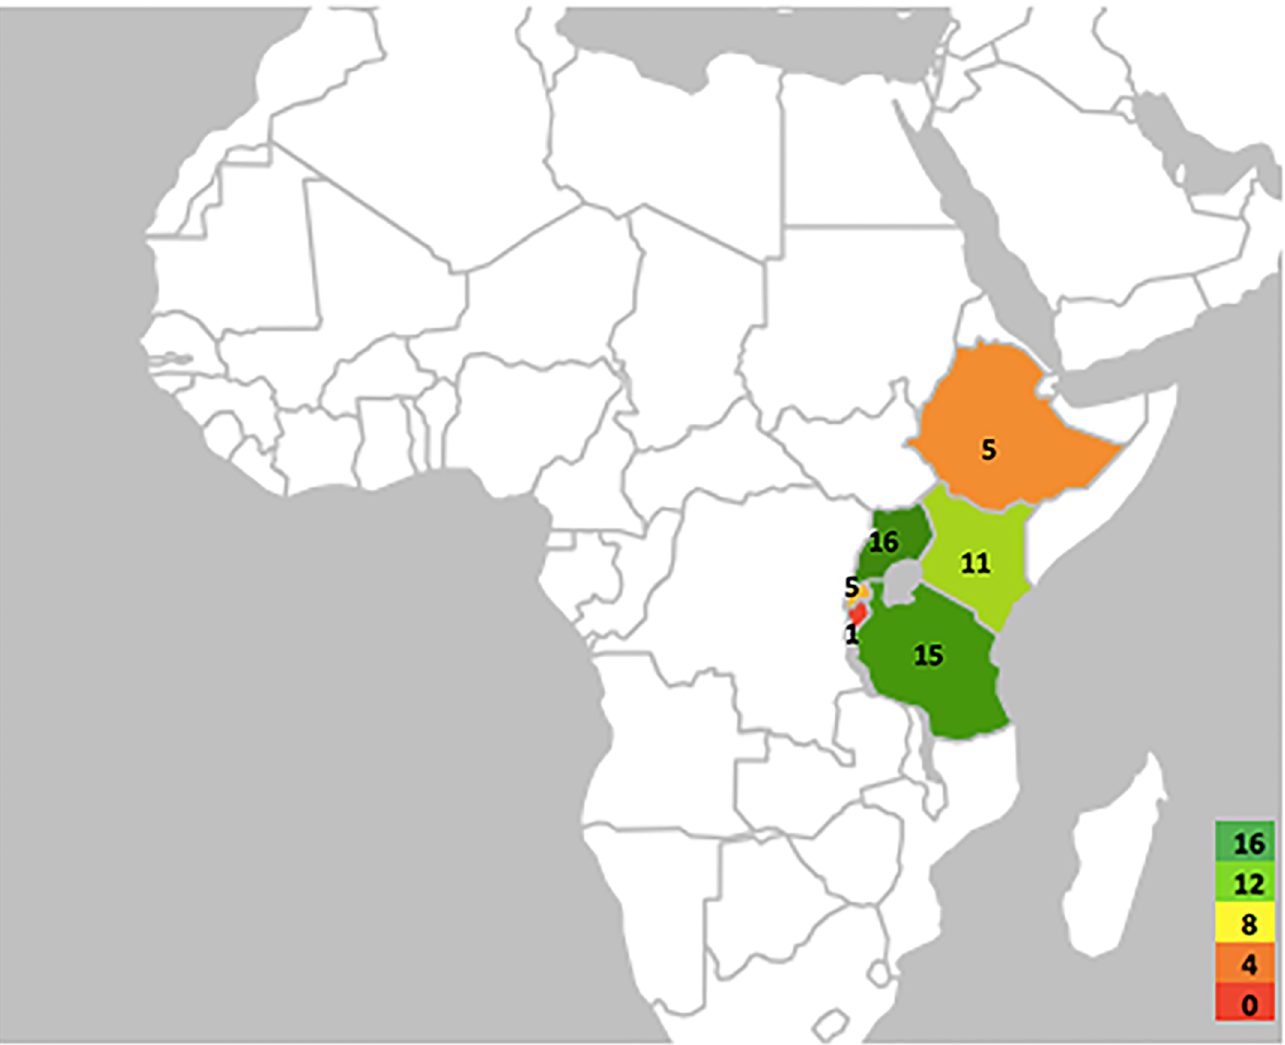
Fig 2. Geographical map of the East African Community indicating the number of studies conducted per